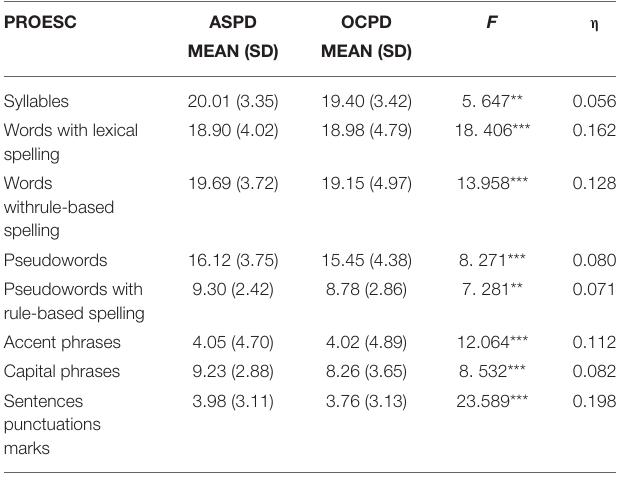
TABLE 3 | PROESC: Mean, standard deviation, significance level, and statistical power of writing (PROESC) of the